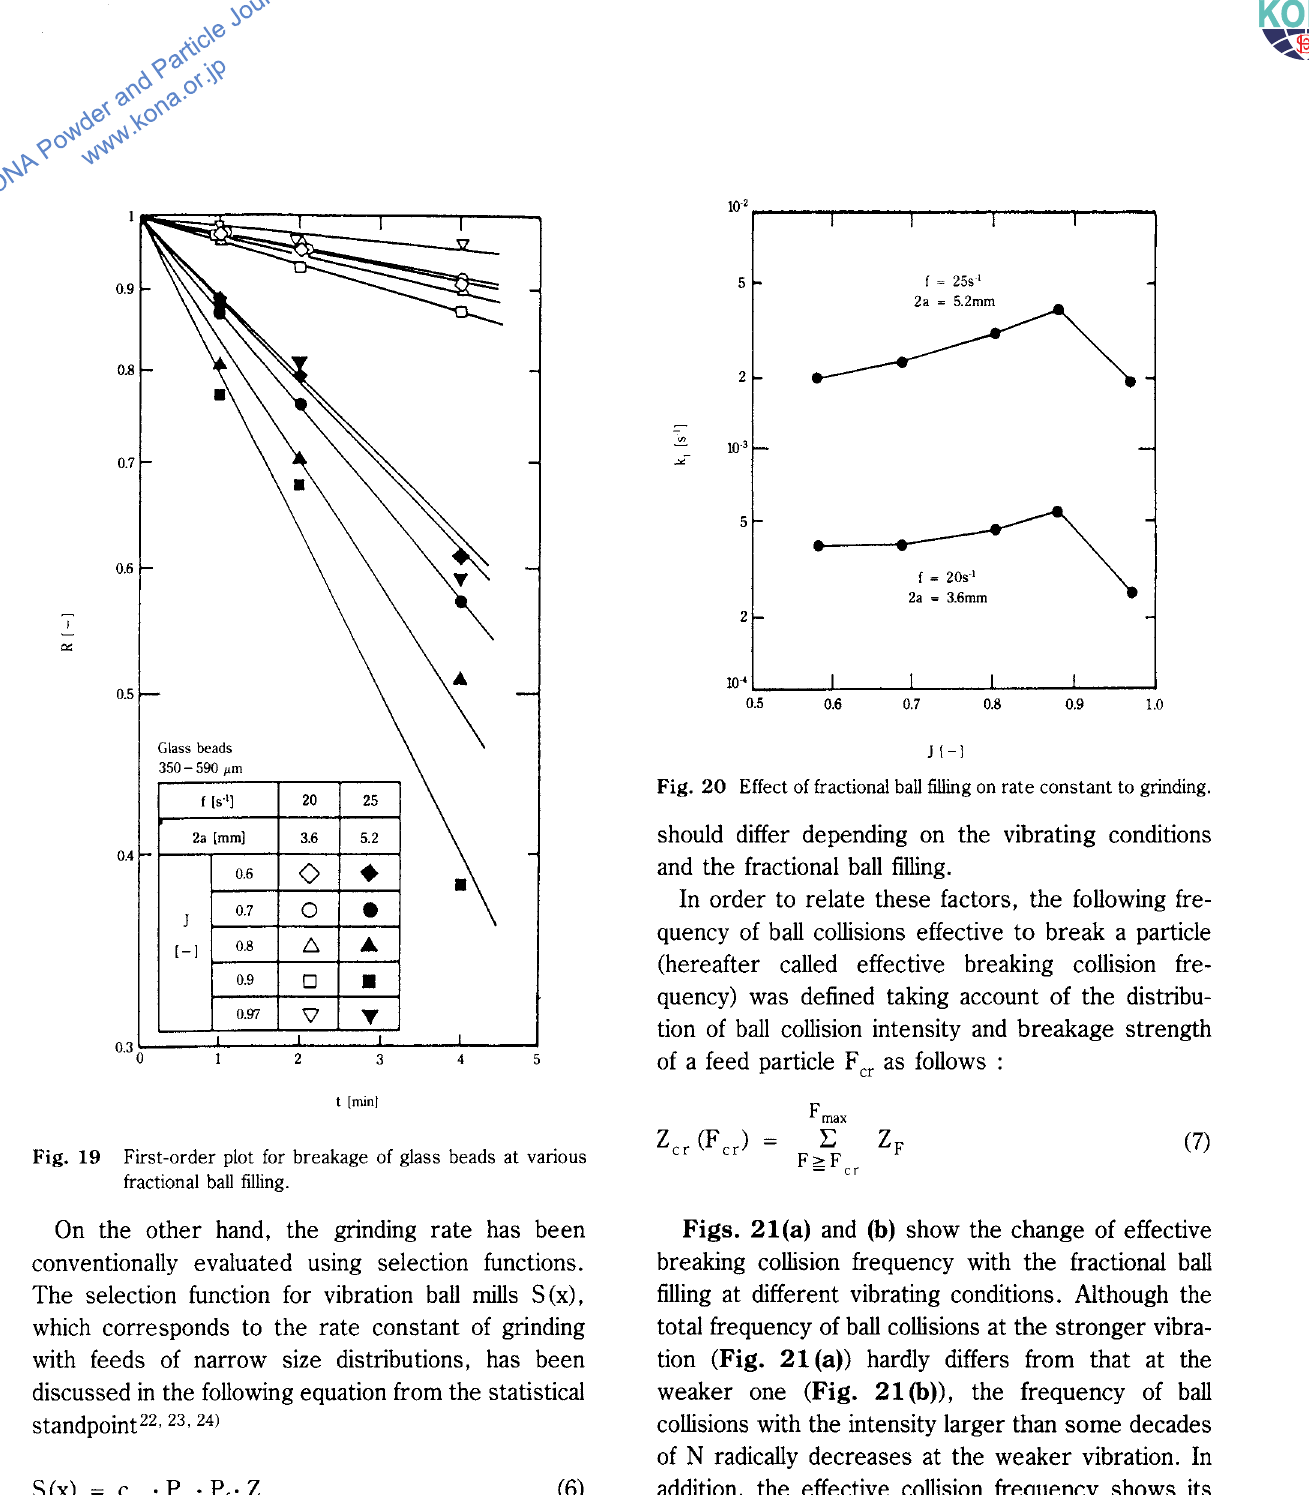
Fig. 20 Effect of fractional ball filling on rate constant to